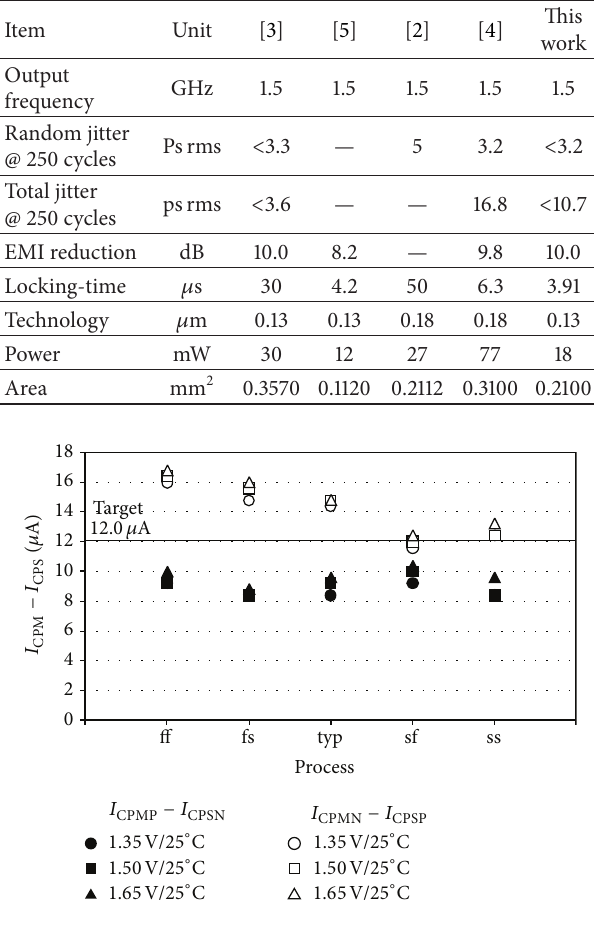
Figure 25: Measurement result of different CP current.